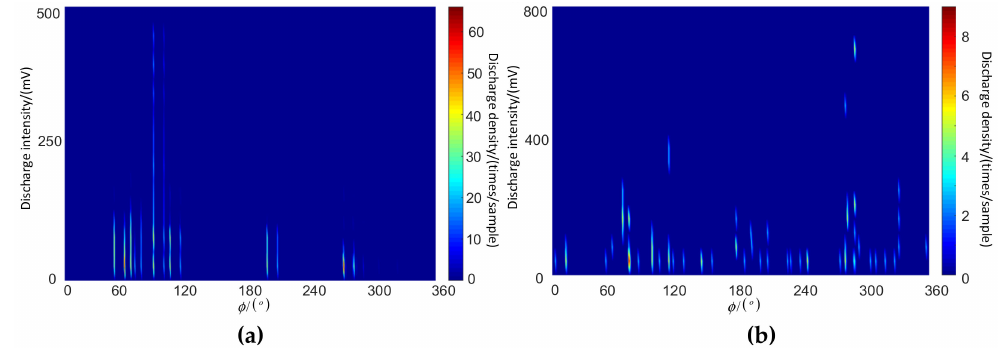
Figure 6. PRPD patterns of the free particle defect under 20 kV. ( a ) A PRPD pattern of the optical detection and ( b ) a PRPD pattern of the UHF